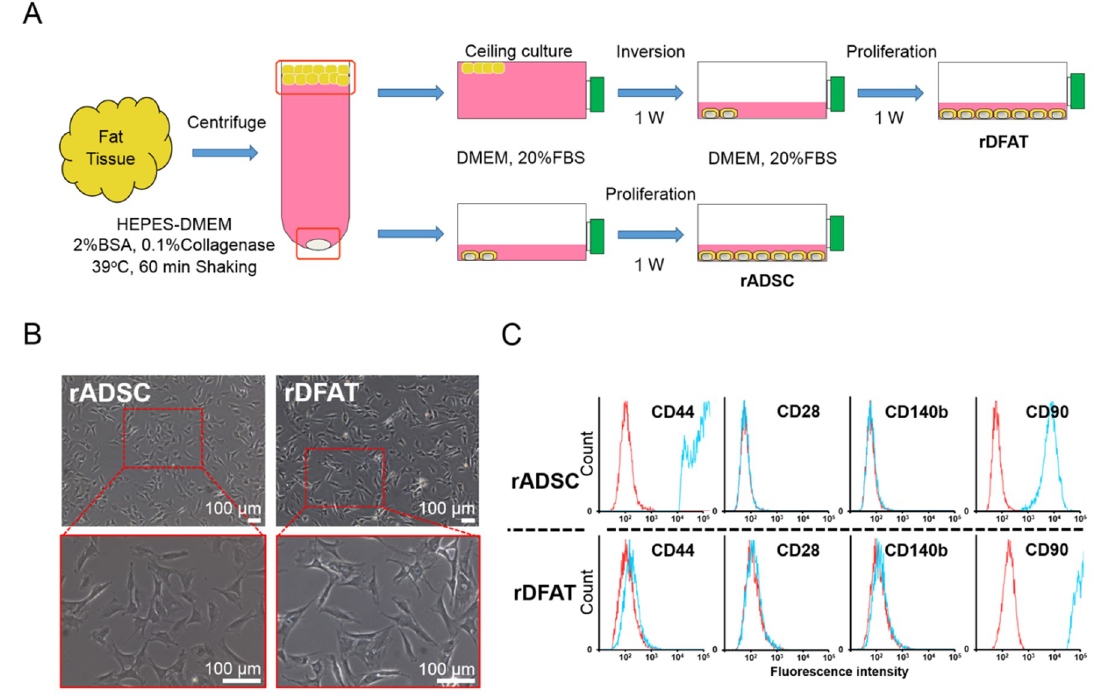
Figure 4. Preparation of the two types of multipotent progenitor cells. ( A ) Scheme of the preparation of the rADSC and rDFAT cells. ( B ) Microscopic view of rADSC and rDFAT cells at first passage. ( C ) Surface antigens on rADSC and rDFAT cells.